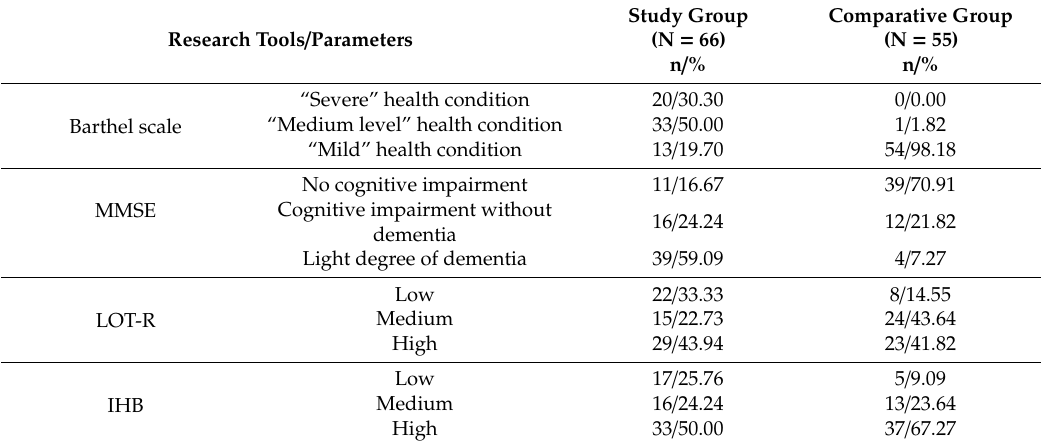
Study Group Comparative Group (N = 66) (N = 55) n / % n / %